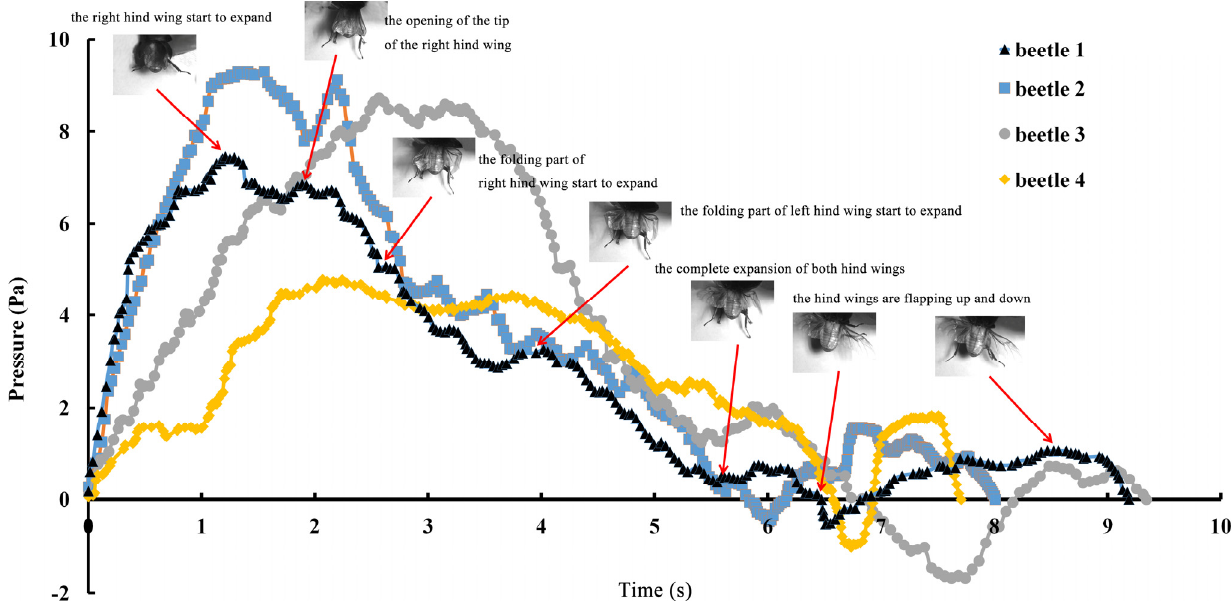
Figure 2. The change in blood pressure in the veins of the hind wings with time. The photos captured with a high-speed camera show the relationship of the unfolding actions of the hind wings with fluctuations in blood